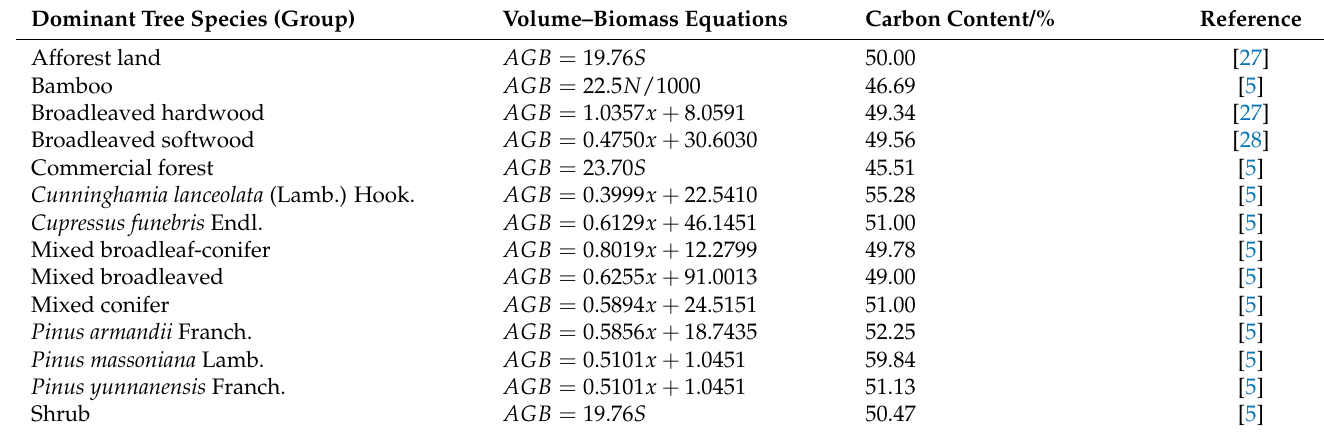
Table 1. Volume–biomass equations and carbon concentration of dominant tree